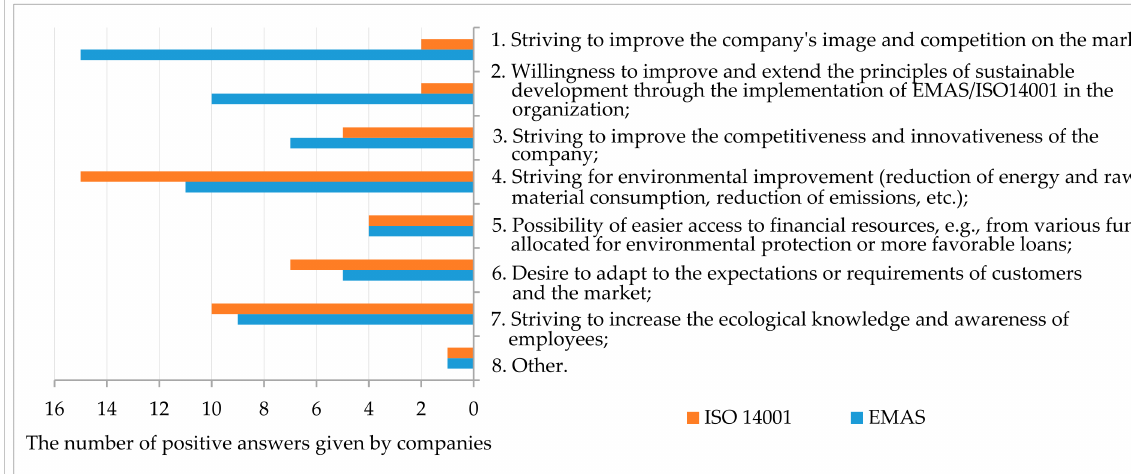
Figure 1. Answers to the first question of the survey: Reasons for EMAS/ISO14001 implementation in